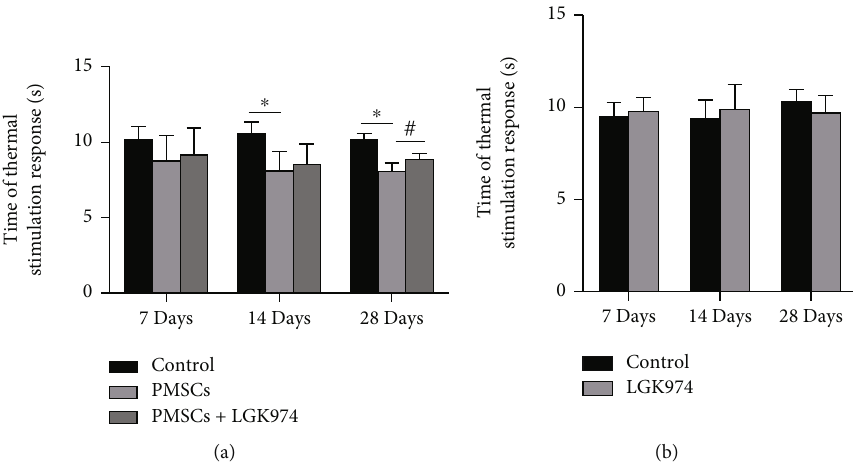
Figure 4: Time of thermal stimulation response(s). There was no di ff erence in time of thermal stimulation response in three groups at 7 days. PMSC treatment signi fi cantly improved thermal stimulus response at 14 and 28 days compared with the control group. LGK974 inhibitor signi fi cantly decreased the therapeutic e ff ect of PMSCs. ∗ PMSC group vs. the control group, P < 0 : 05 ; # PMSC group vs. PMSC +LGK974 group, P < 0 : 05 (a). No signi fi cant di ff erence between control group and LGK974 group at 7, 14, and 28 days